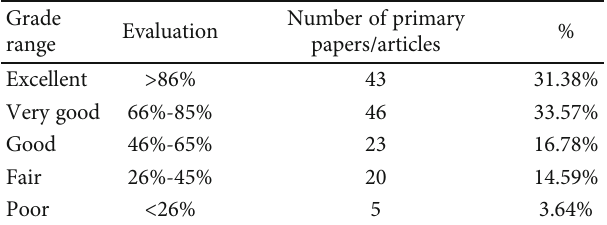
Table 6: Quality levels. Source: